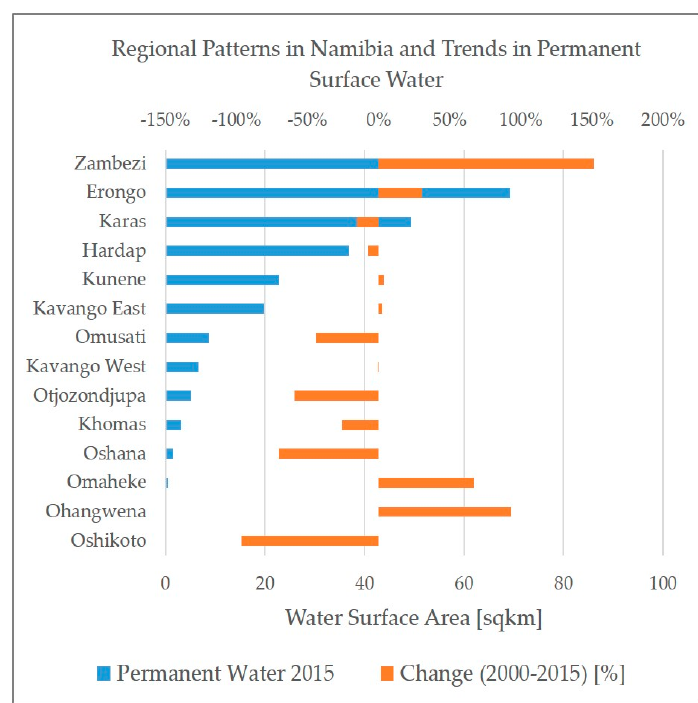
11 of 28 Figure 5. Comparison C: Okavango at Divundu GSW for September 2015 (orange) with Sentinel-2A L1C NDWI (blue >0.5) from 18 September 2015 and overlap (grey). The three examples (Figures 3–5) illustrate that the procedure chosen for the GSW dataset, with